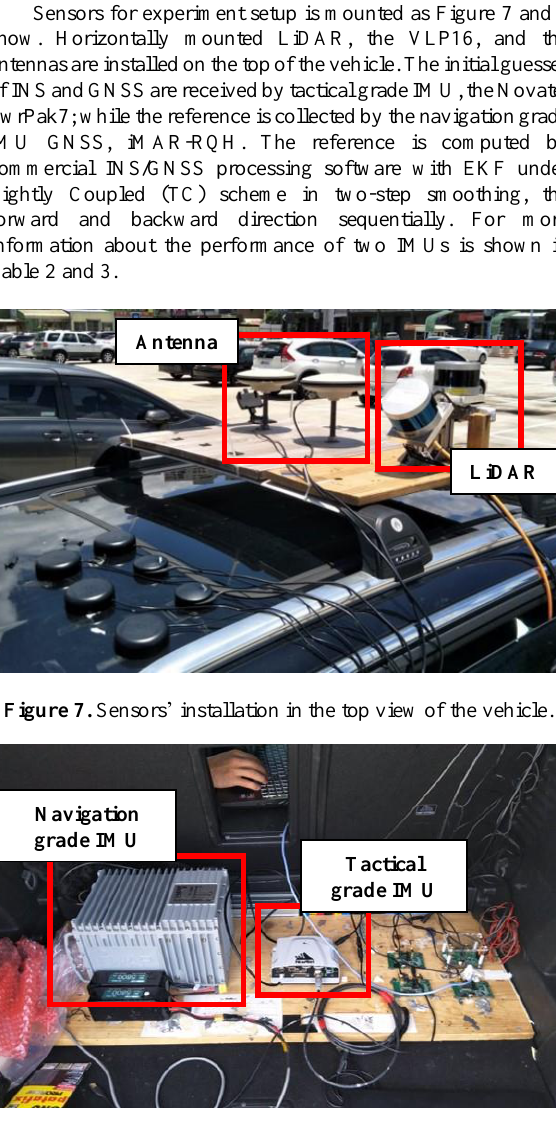
Figure 8. Sensors’ installation interior view of the vehicle.